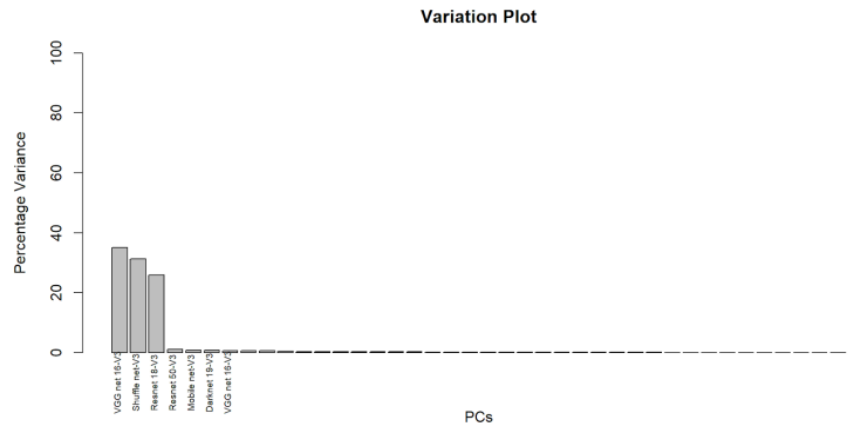
Figure 5. Percentage variance of each feature according to PCA. The first three features contribute the most to the variability of the data.